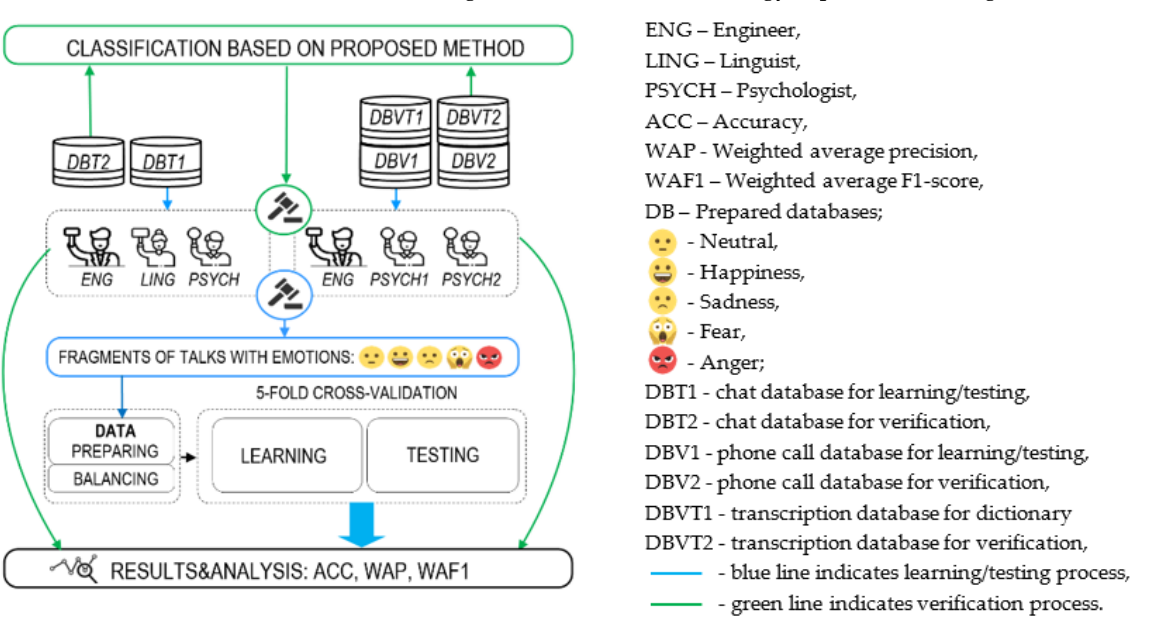
Figure 1. Research methodology.